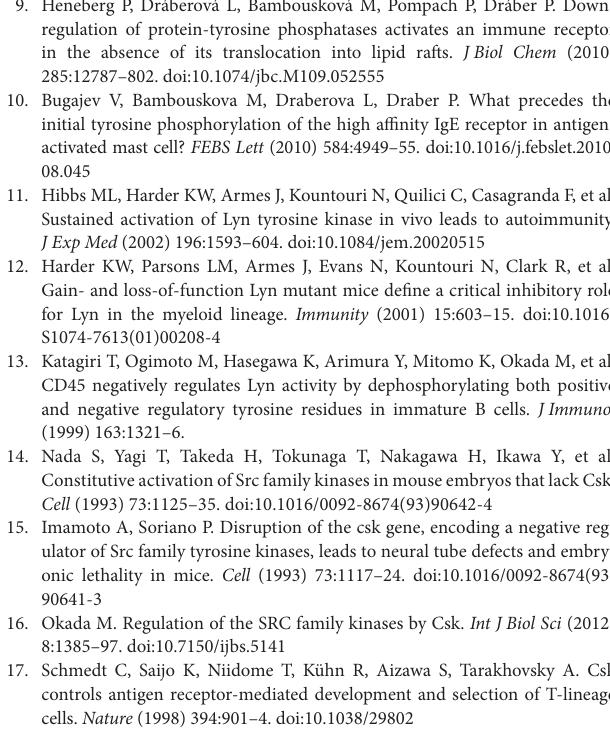
experiments as in Figure 1g ; fluorescence was normalized to pLKO.1 and pCDH controls. The results in (B,D,F,h) represent means ± SEM from 5–13 independent experiments. FigUre s2 | Phosphorylation of LYN and FYN at Y397 is unchanged in bone marrow-derived mast cells (BMMCs) with CSK-KD. (a) IgE-sensitized BMMCs with CSK-KD or control pLKO.1 cells were activated or not with antigen (250 ng/ml) for 3 min. The cells were lysed and Lyn was immunoprecipitated with LYN-specific antibody. Phosphorylation was analyzed by immunoblotting (IB) with phospho-SFK antibody (pSFK Y397 ). Amount of LYN was determined with Lyn-specific antibody. (B) Densitometry analyses of the pSFK Y397 were performed from immunoblots as in panel (a) , in which signals from tyrosine- phosphorylated proteins in activated cells were normalized to the signals in nonactivated cells and amount of LYN. (c) BMMCs were activated as in panel (a) and FYN from the cell lysates were immunoprecipitated with FYN-specific antibody. Immunoprecipitates were analyzed by immunoblotting with antibody specific for pSFK Y397 and FYN antibody as in panel (a) . (D) Densitometry analyses of the pSFK Y397 were performed from immunoblots as in panel (c) , in which signals from tyrosine-phosphorylated FYN proteins in activated cells were normalized to the signals from nonactivated cells and amount of FYN. In (a,c) representative immunoblots from three experiments are shown. Means ± SEM were calculated from three independent experiments. Differences between pLKO.1 and CSK-KD in (B,D) were not statistically significant as determined using unpaired two-tailed Student’s t -test. FigUre s3 | Production of PAG-KO bone marrow-derived mast cells (BMMCs) with reduced CSK expression. (a) CSK protein expression determined by immunoblotting with whole-cell lysates from PAG-KO BMMCs transduced with CSK-specific shRNAs (pooled shRNAs; CSK-KD) or empty pLKO.1 vector. GRB2 was used as a loading control. (B) Quantification of the relative amounts of CSK normalized to the amounts of GRB2 used as a loading control and the CSK level in pLKO.1 control cells. (c) Flow cytometry analysis of the surface presence of Fc ɛ RI and c-KIT receptors in PAG-KO BMMCs with CSK-KD and corresponding controls. (D) Quantification of surface Fc ɛ RI and c-KIT, obtained in the experiments as in panel (c) ; fluorescence was normalized to pLKO.1 controls. The data in (B,D) represent means ± SEM from 5–8 independent